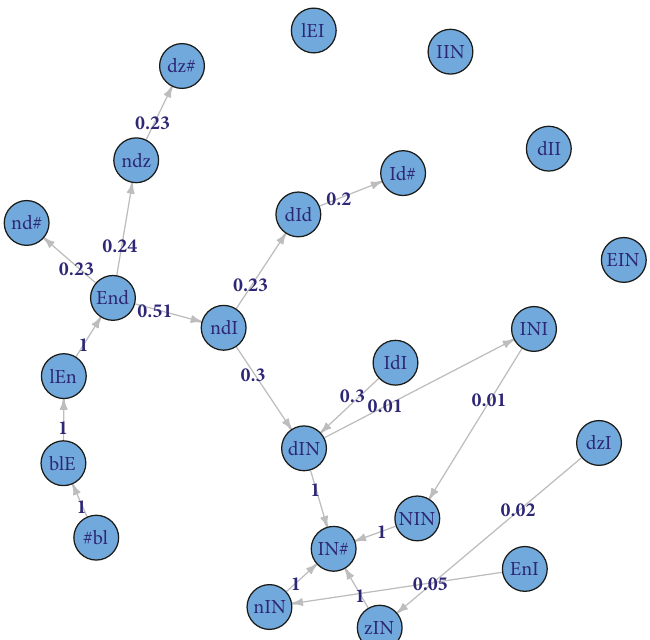
Figure 9: The directed graph for blending . Vertices represent triphones, including triphones such as IIN that were posited by the graph algorithm to bridge potentially relevant transitions that are not instantiated in the training data. Edges are labelled with their edge weights. The graph, the edge weights of which are specific to the lexomes blend and continuous, incorporates not only the path for blending , but also the paths for blend , blends , and blended